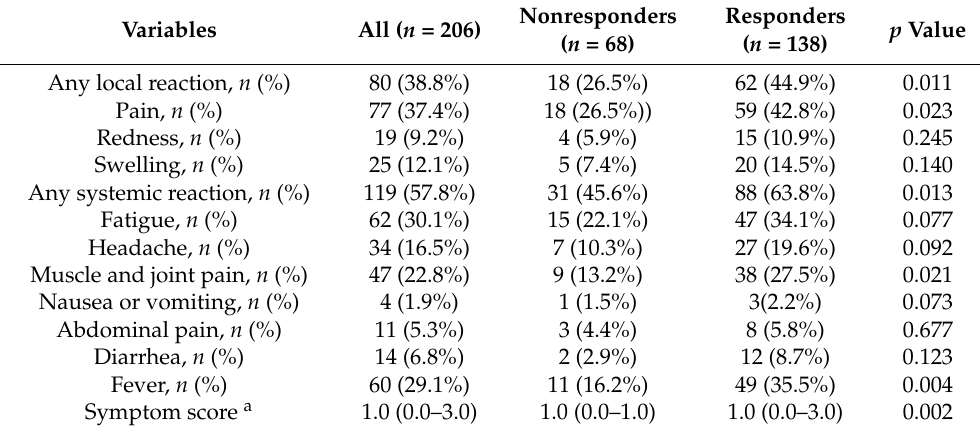
Table 2. Solicited local and systemic reactions to the ChAdOx1 nCoV-19 vaccine reported 0 to 7 days after vaccination in hemodialysis patients according to their anti-spike IgG antibody response at day 28.